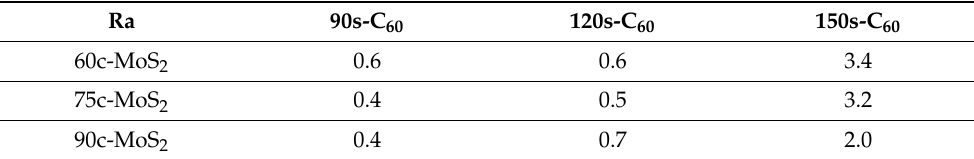
Figure 5. AFM characterization of ( a ) 60c-MoS 2 nanolayer; ( b – d ) 60c-MoS 2 -90s/120s/150s-C 60 nanolayer; ( e ) 75c-MoS 2 nanolayer; ( f – h ) 75c-MoS 2 -90s/120s/150s-C 60 nanolayer; ( i ) 90c-MoS 2 nanolayer; ( j – l ) 90c-MoS 2 -90s/120s/150s-C 60 nanolayer. Table 3. Average surface roughness of MoS 2 /C 60 composite